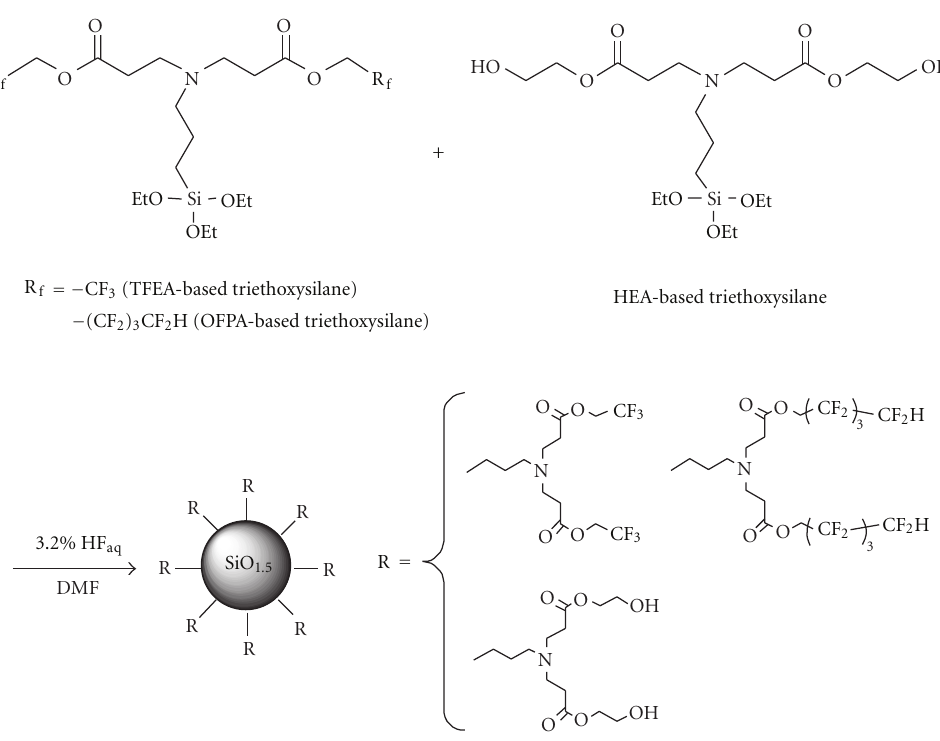
Figure 9: Synthetic route for the amphiphilic silsesquioxane-based hybrids based on hydrolytic cocondensation of the hydroxyl- functionalized triethoxysilane precursor and fluorinated triethoxysilane